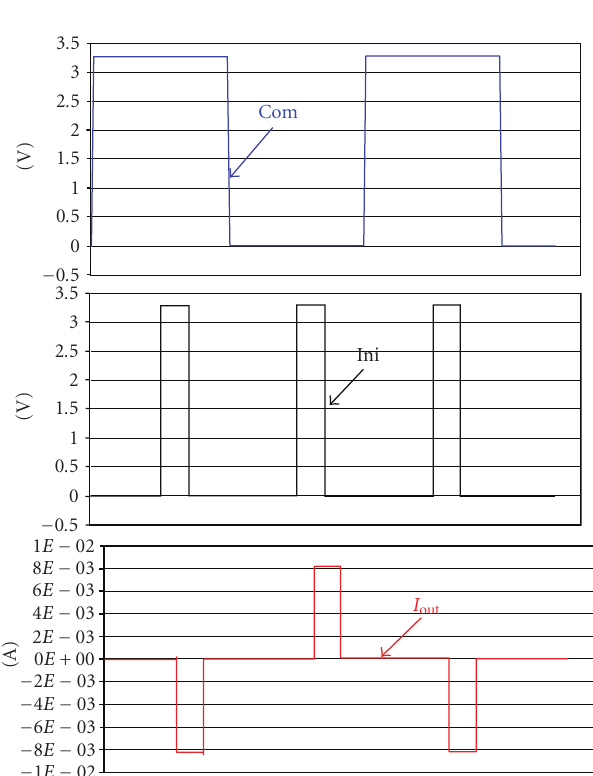
Figure 15: Output waveforms of the bidirectional writing current generator shown in Figure 14, obtained in 0.35 μ m CMOS technol- ogy under a V dd = 3 .